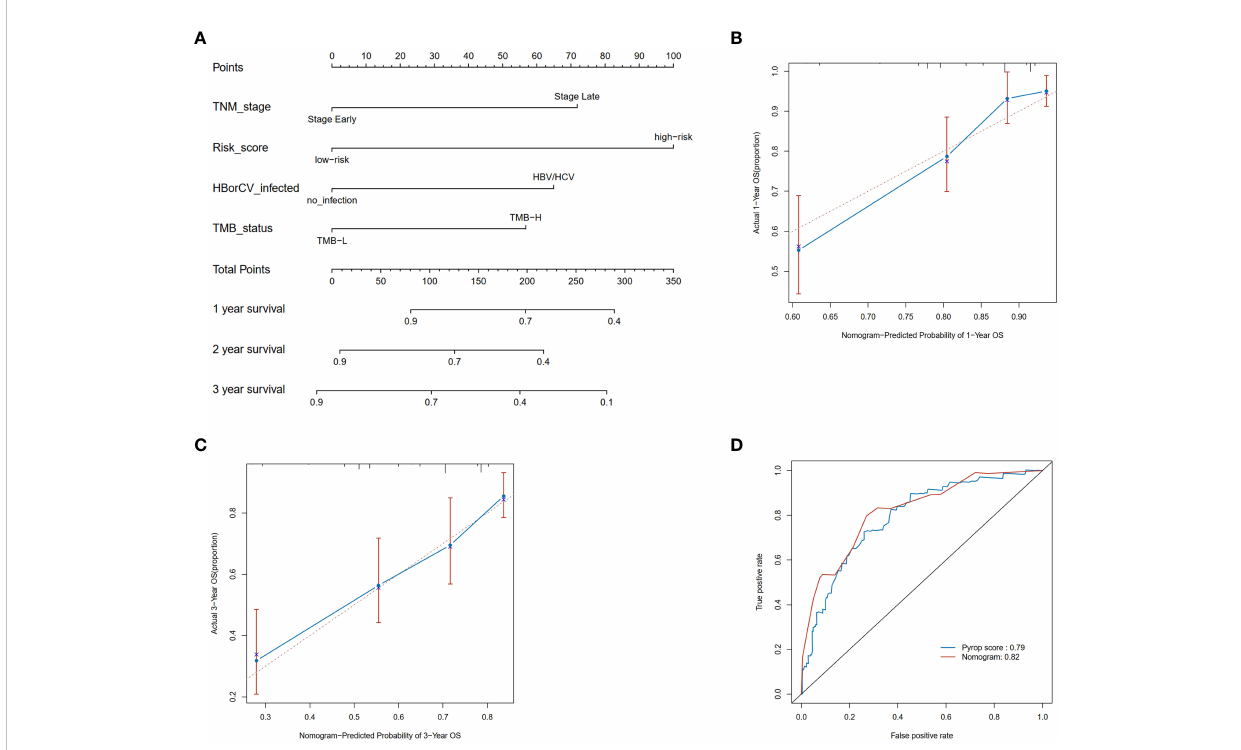
FIGURE 4 Construction and validation of a nomogram. (A) Nomogram for predicting the 1-, 2-, and 3-year OS of HCC patients in the TCGA cohort. (B) Calibration plots of the nomogram to predict OS at 1-year; (C) Calibration plots of the nomogram to predict OS at 3-year; (D) ROC curve of the nomogram and the risk model in the TCGA cohort at 1 year.